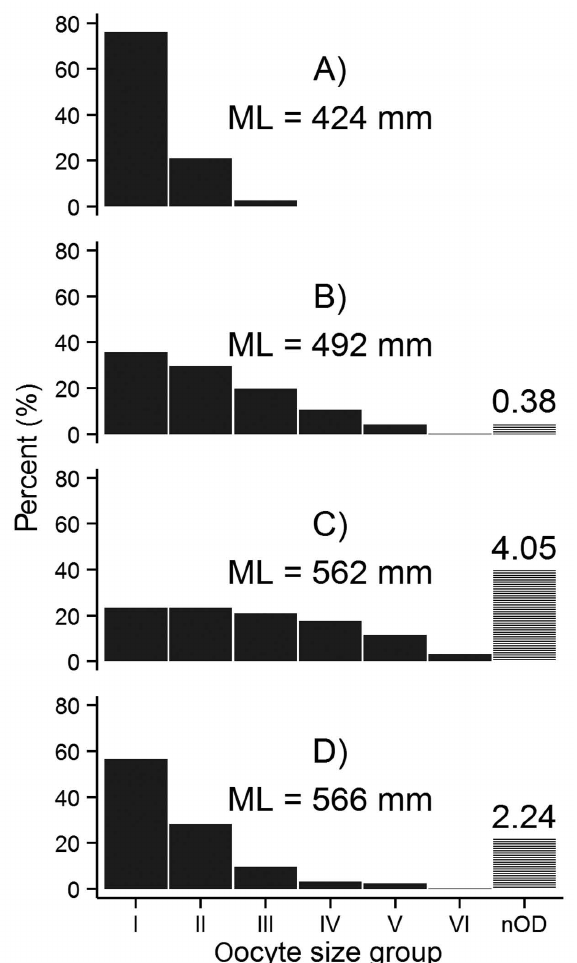
Fig. 6. – Frequency distribution of the different size groups of oo- cytes within the ovary of (a) immature, (b) maturing, (c) mature, and (d) spawning state (after the first spawning event) females of Om- mastrephes bartramii . ML, mantle length; nOD, number of oocytes in oviducts (in millions).